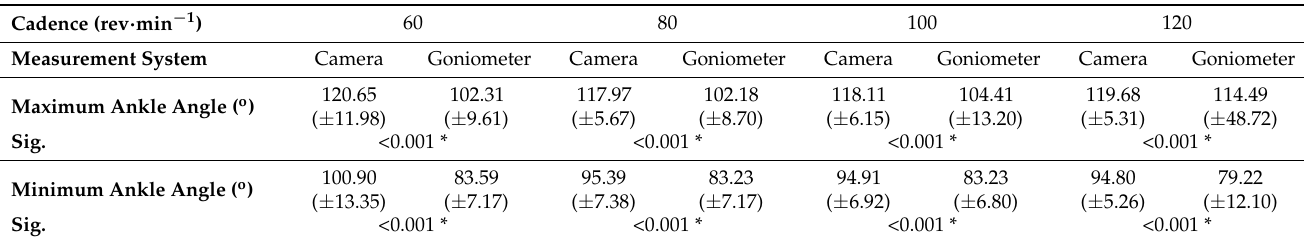
Table 4. Comparison of mean maximum and mean minimum ankle angle recorded across 10 pedal